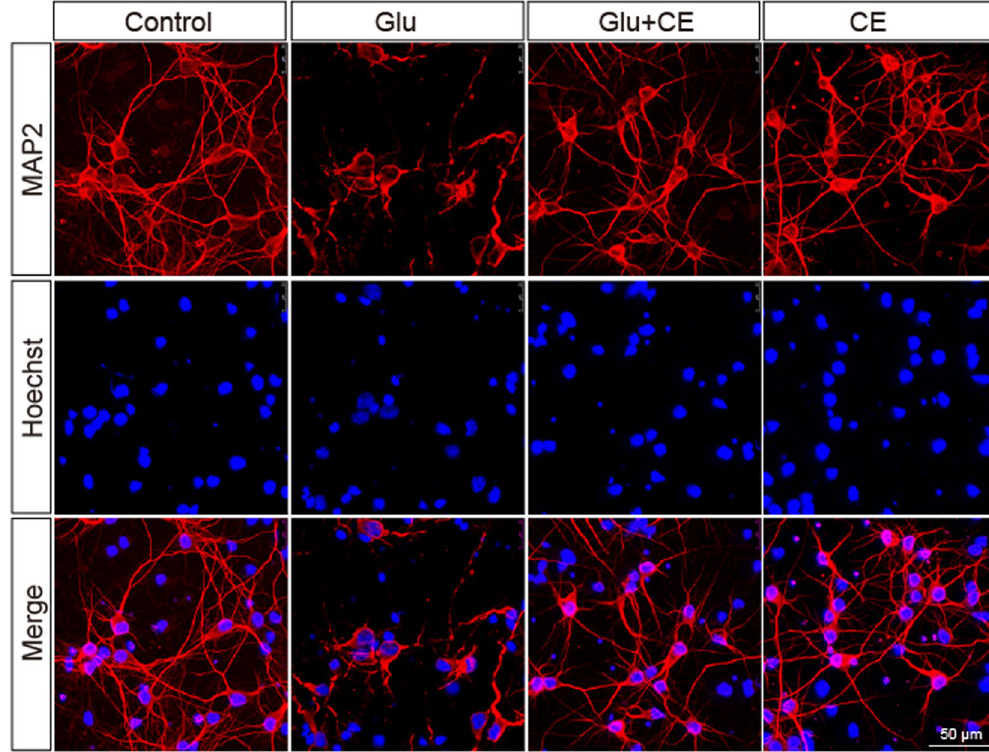
Figure 3. The morphological integrity of neurons is rescued by CE. Immunofluorescence staining was performed using an anti-MAP2 antibody, followed by an Alexa Fluor ® 546-conjugated secondary antibody. Nuclei were co-immunostained with Hoechst 33258. Images were acquired using a Leica confocal microscope. Three independent experiments were performed; at least 20 photomicrographs from each group were analysed. Scale bar, 50 μ